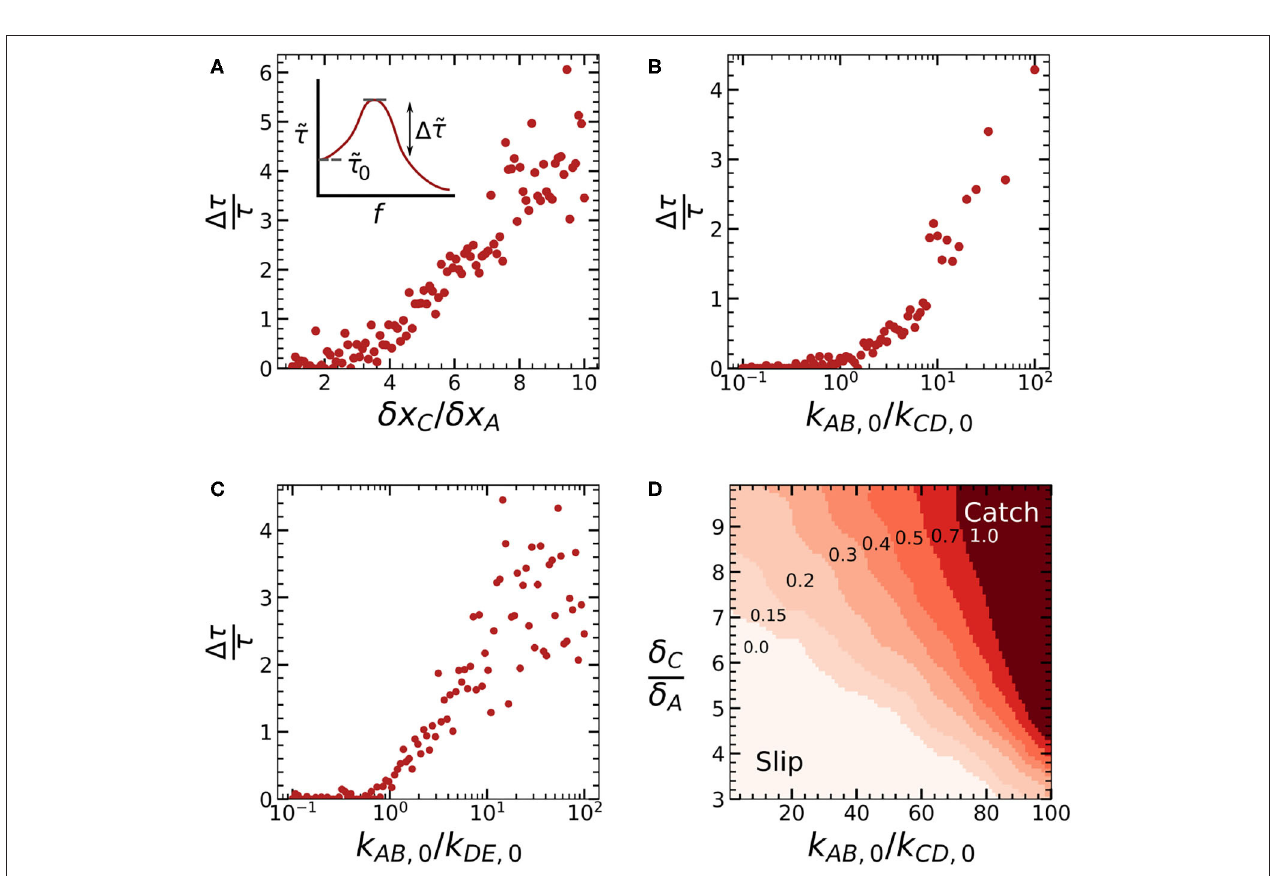
FIGURE 3 | Force-lifetime curves simulated at varying δ x C /δ x A (A) , k AB ,0 / k CD ,0 (B) , and k AB ,0 / k DE ,0 (C) . Data was recorded at δ x C /δ x A = 6.4 (B,C) , k AB ,0 / k CD ,0 = 20 (A,C) , and k AB ,0 / k DE ,0 = 10 (A,B) . All data are averages of 1,000 simulations per force, at N A = N C = 1, dx DE = dx AB = 1, k ED ,0 = k BA ,0 = 1, and k AB ,0 =